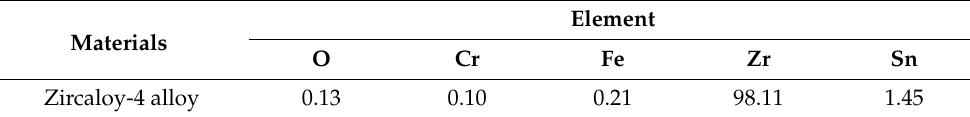
Table 1. Chemical composition of Zircaloy-4 alloy in wt.%.